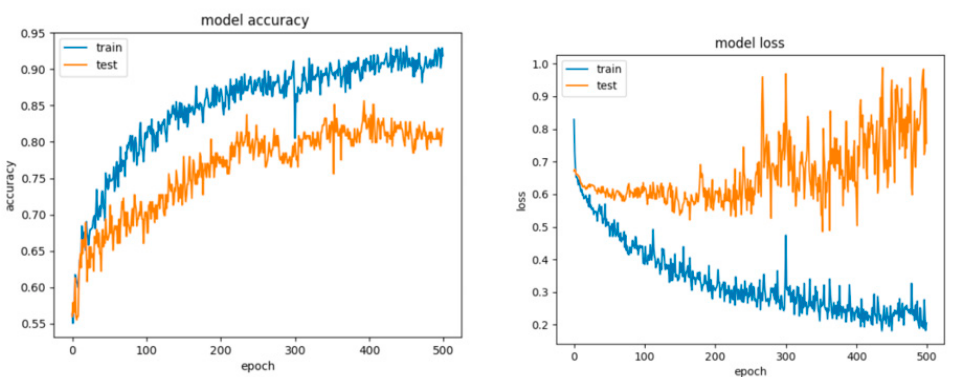
Figure 21. Accuracy and loss for Configuration 4, non-overlapping dataset.